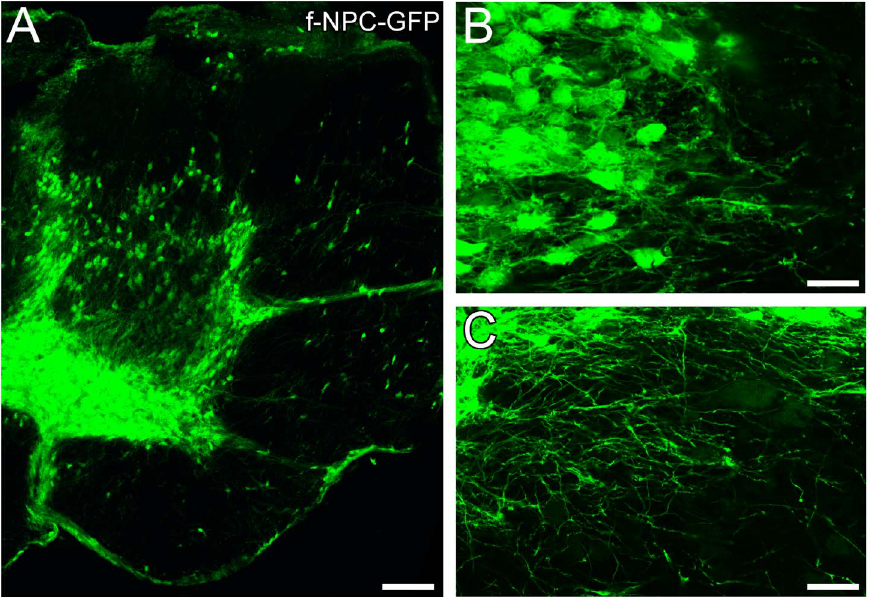
Figure 9. Integration of human fetal neural progenitor cells following transplantation into neonatal spinal cords with SCC injuries. (A) Transverse section showing GFP-positive f-NPC-derived cells 29 days post-injury. (B, C) Higher magnification views of GFP-positive f-NPC-derived cells showing morphological differentiation including the extension of thin, ramified processes. Scale bars: 20 m m (A), 32.5 m m (B, C).